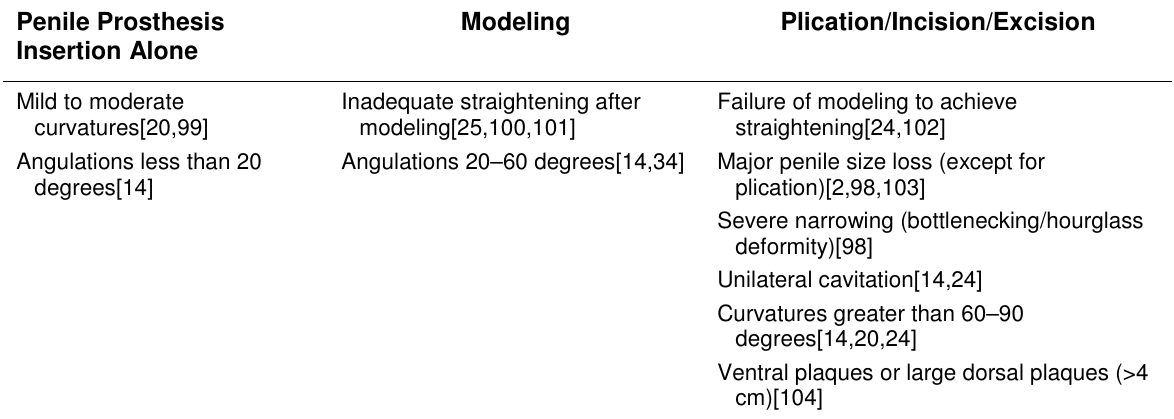
Indications for Modeling vs. Plication/Incision/Excision Procedures during Penile Prosthesis Implantation in